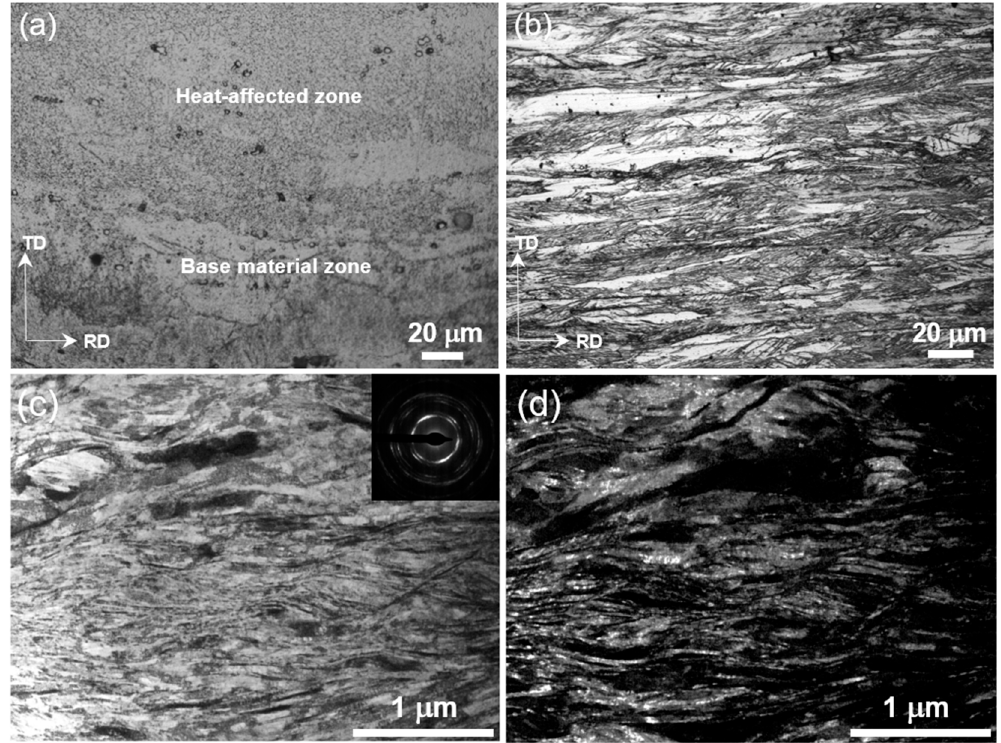
Figure 4. Microstructure of side layers in HS sample. ( a ) OM image at the boundary between the heat-affected zone and the base material zone; ( b ) OM image of the base material zone; and ( c , d ) TEM images of the base material zone.